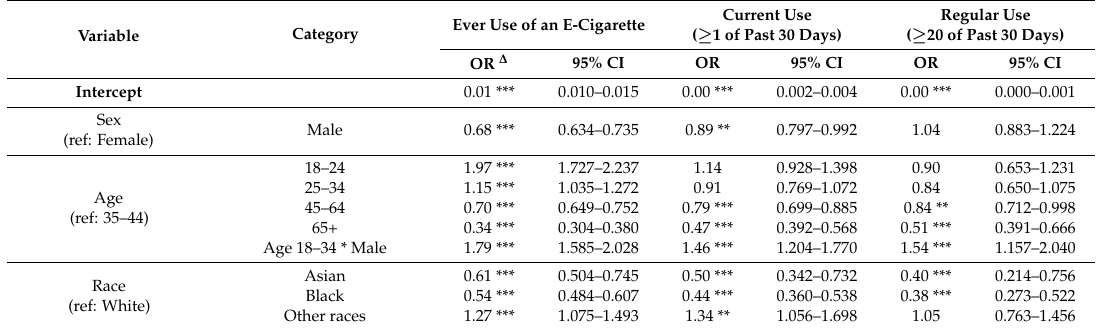
Table 2. Odds ratios for ever, current and regular measures of e-cigarette use, CPS-TUS,